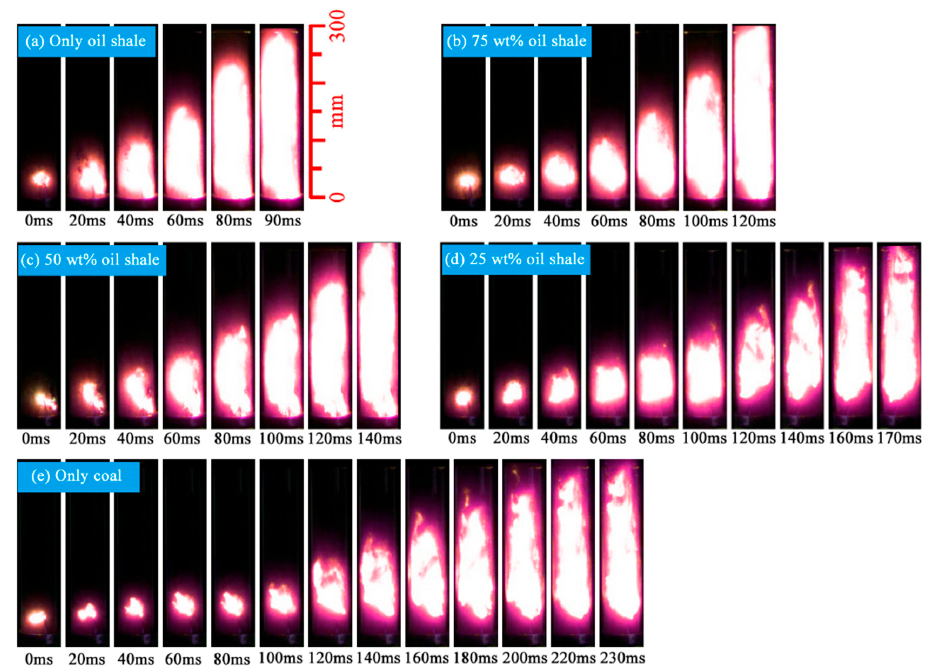
Figure 5. High-speed photos of flame propagation of the dust cloud in the vertical glass tube: ( a ) only oil shale; ( b ) 75 wt% oil shale; ( c ) 50 wt% oil shale; ( d ) 25% oil shale; ( e ) only coal.